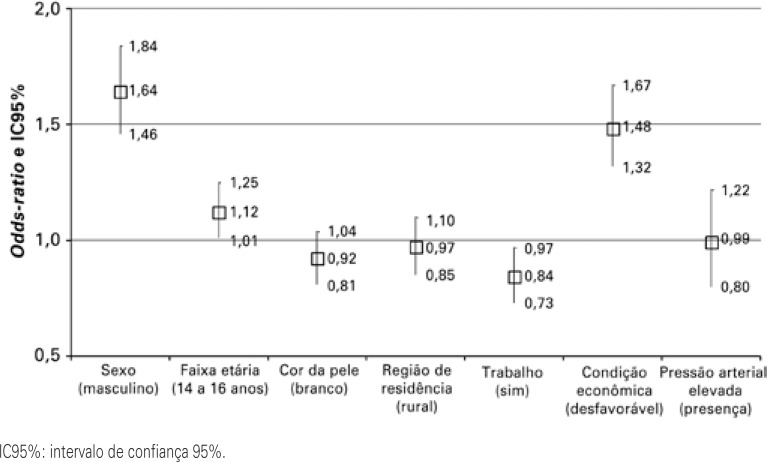
Associação ajustada entre variáveis demográficas e pressão arterial elevada com a não medição da pressão arterial nos últimos 12 meses como variável dependente